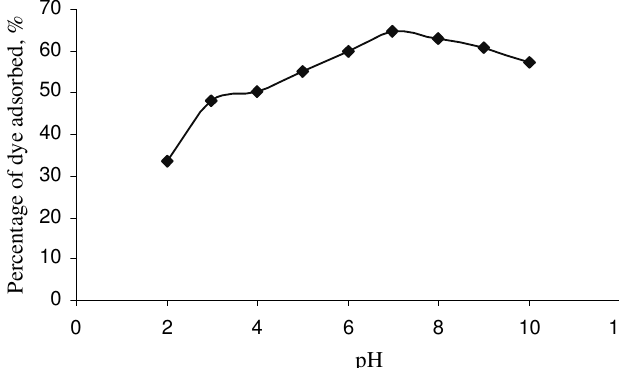
Figure 3. Effect of initial pH on adsorption of Grey BL by mango leaves (dye concentration: 100 mg/L; sorbent dose: 1 g/L; particle size: 400 µ , contact time: 5 h; Temperature 300